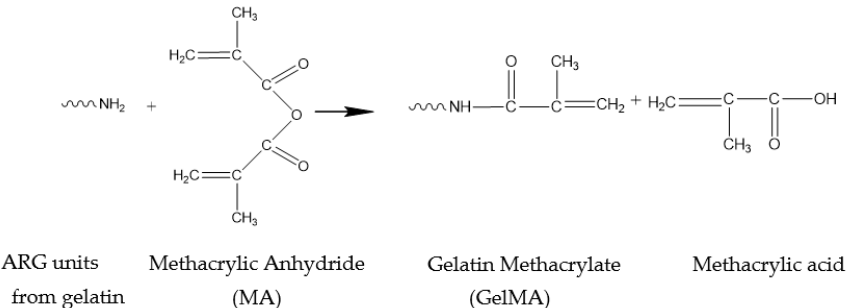
Figure 1. Methacrylation of gelatin.